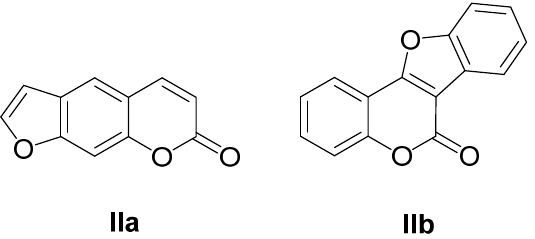
Figure 6. Psoralene ( IIa )- and coumestan ( IIb )-type natural furocoumarins. It was demonstrated that furocoumarins 34 – 43 inhibit HIV replication in H9 cells with an EC 50 in the range of up to 0.37 µ M (Table 3) [30,58]. Among them, the most active are psoralen 33 (EC 50 = 0.54 and TI = 191), bergapten 35 (EC 50 = 1.63 and TI = 70), imperatorin 36 (EC 50 < 0.37 and TI > 1000) and heraclenol 40 (EC 50 = 0.38 and TI = 870) [30,58]. Subsequently, Sancho and colleagues showed that imperatorin 36 showed no activity against RT and integrase [59]. However, it inhibits the critical transcription factor Sp1 and blocks infected cells in the G1 phase of the cell cycle. This indicates its potential therapeutic role in the treatment of HIV infections by inhibiting cellular factors that regulate HIV-1 replication at the transcriptional level